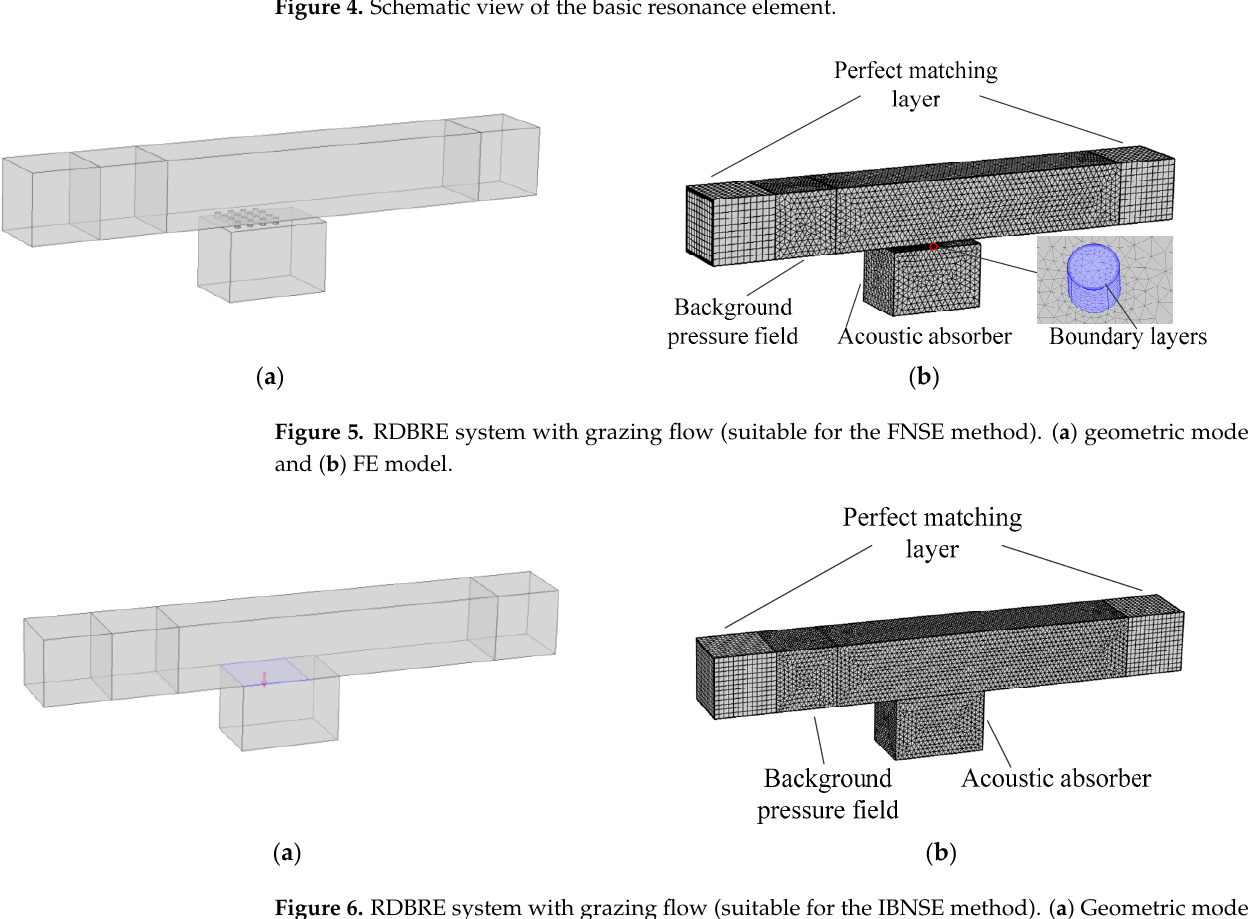
( d ) Figure 7. Comparisons of transmission loss using different impedance models. ( a ) Different Mach number; ( b ) different hole diameters; ( c ) different perforation rates; ( d ) different frequencies.